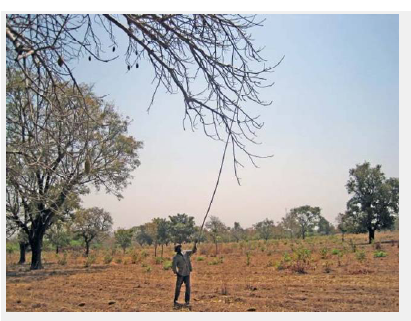
Figure 4.4 Baobab